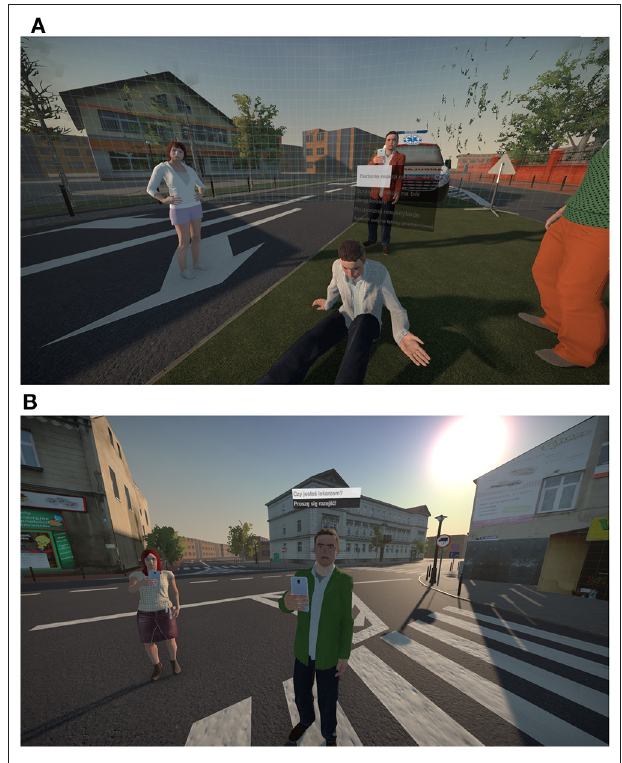
FIGURE 3 | Screenshots showing the context menu in use: for a victim, during an action (A) and for a bystander, before choosing an action (B)